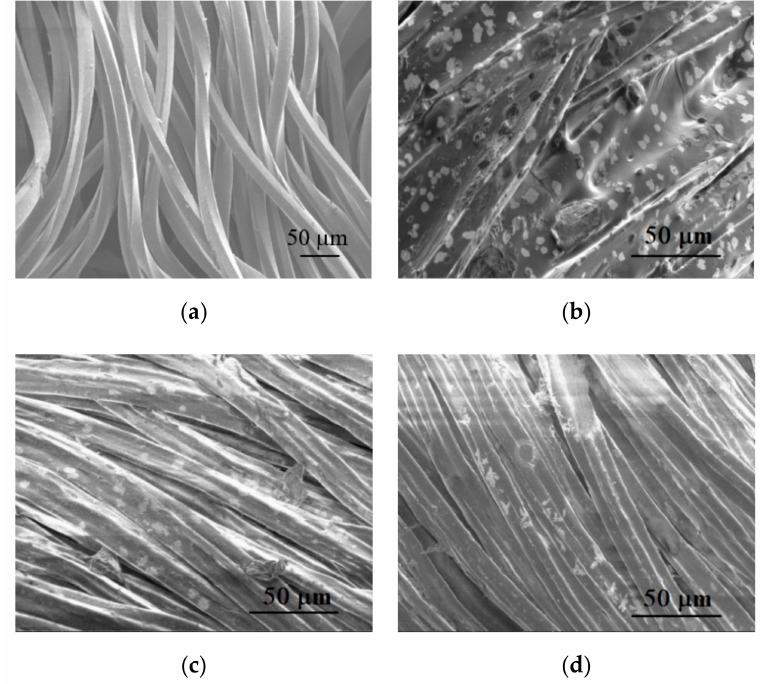
Figure 3. SEM images of the control ( a ) C and treated samples: ( b ) C1 , ( c ) C3 , ( d ) C4